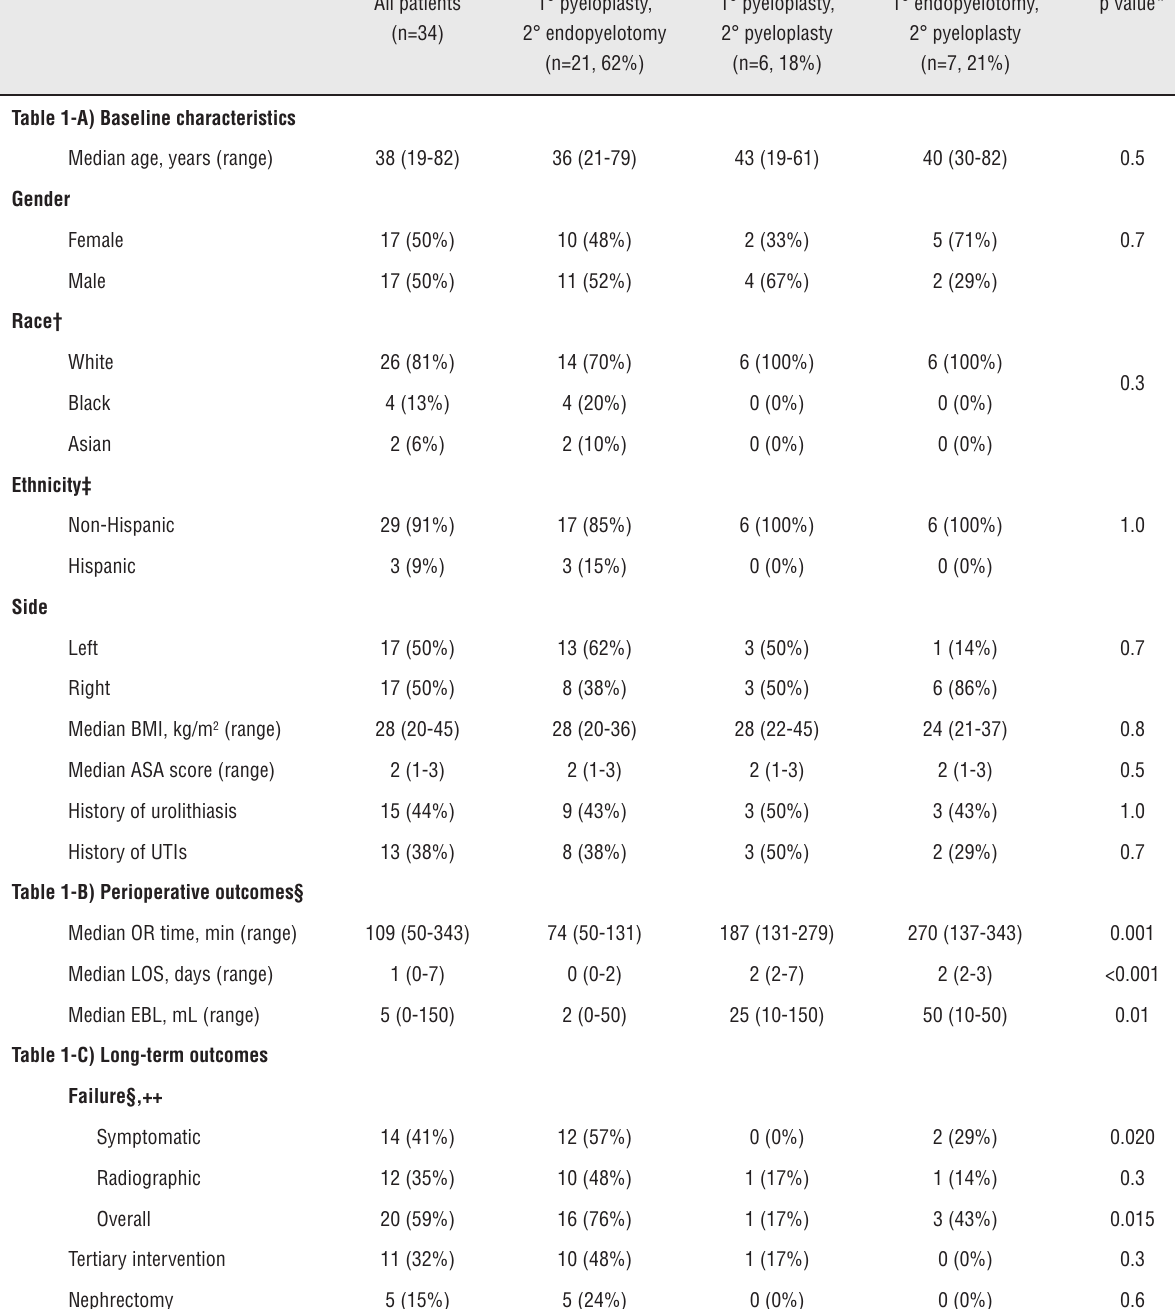
Table 1 - (A) Baseline characteristics, (B) perioperative outcomes, and (C) long-term outcomes of patients undergoing